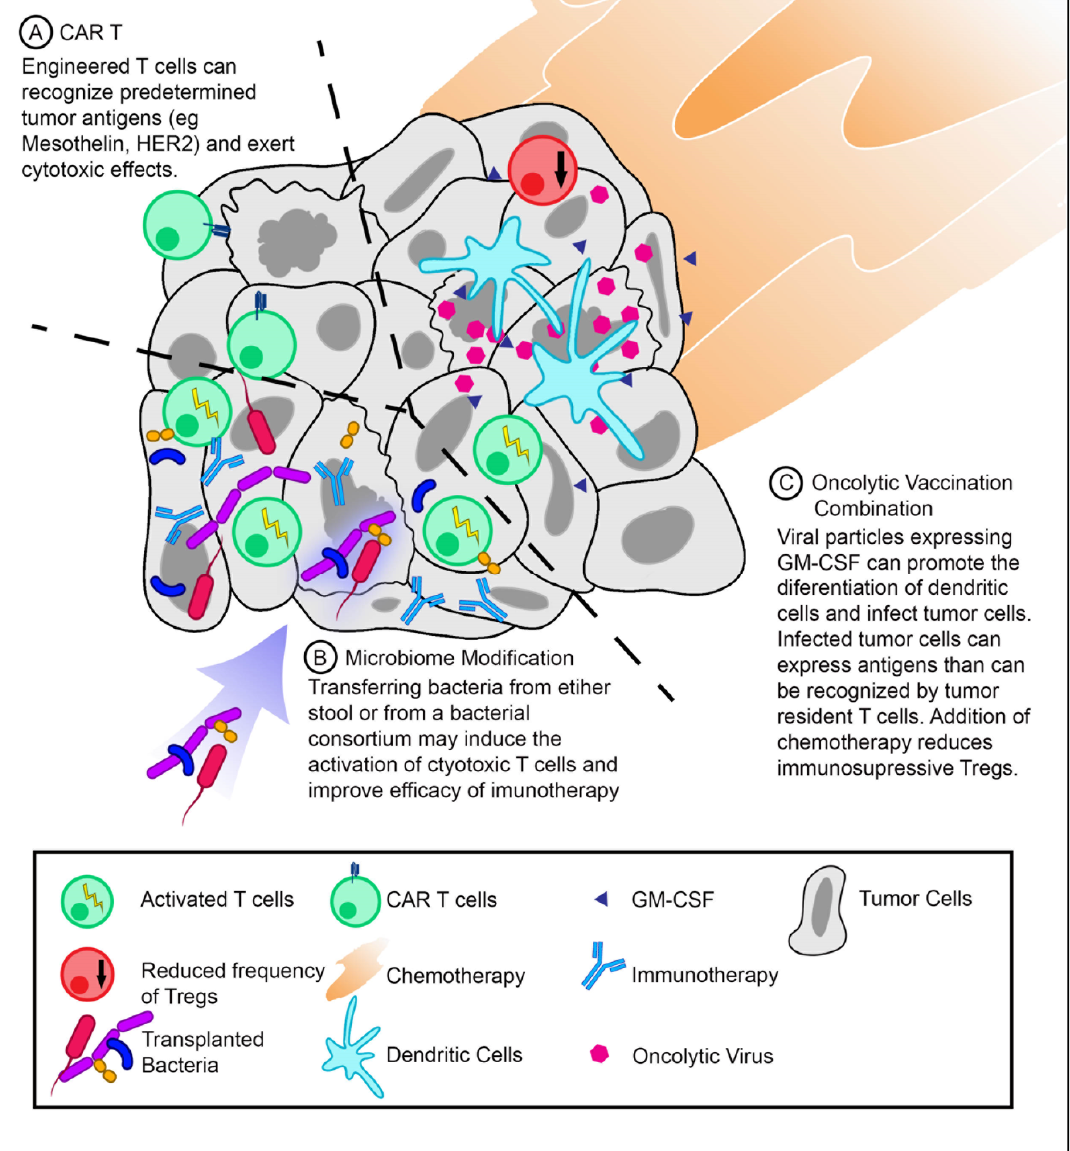
Figure 1. T-cell activation strategies for pancreatic ductal adenocarcinoma (PDAC) treatment. ( A ) Infusion of chimeric antigen receptor T-cells (CAR T-cells) against PDAC tumor antigens. CAR T-cells can recognize antigens specific for their CARs and exert cytotoxic effects. ( B ) Modifying the tumor microbiome may introduce novel antigens that can activate T-cells and improve the efficacy of immunotherapeutics. ( C ) Therapeutic vaccination with oncolytic viruses expressing granulocyte–macrophage colony-stimulating factor (GM-CSF) in combination with chemotherapy (low-dose cyclophosphamide) can increase the frequency of dendritic cells while decreasing the frequency of Tregs.